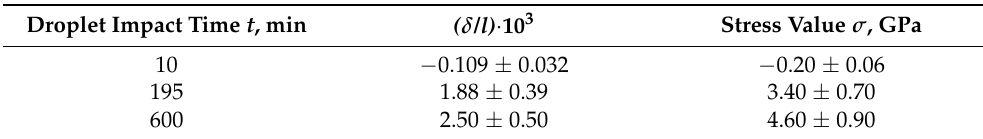
Table 1. Results of determining the average reduced normal curvature of 20Kh13 steel samples without modification and stresses in the surface layer caused by droplet impact of various durations at S imp = 250 m/s, d k = 150 µm.